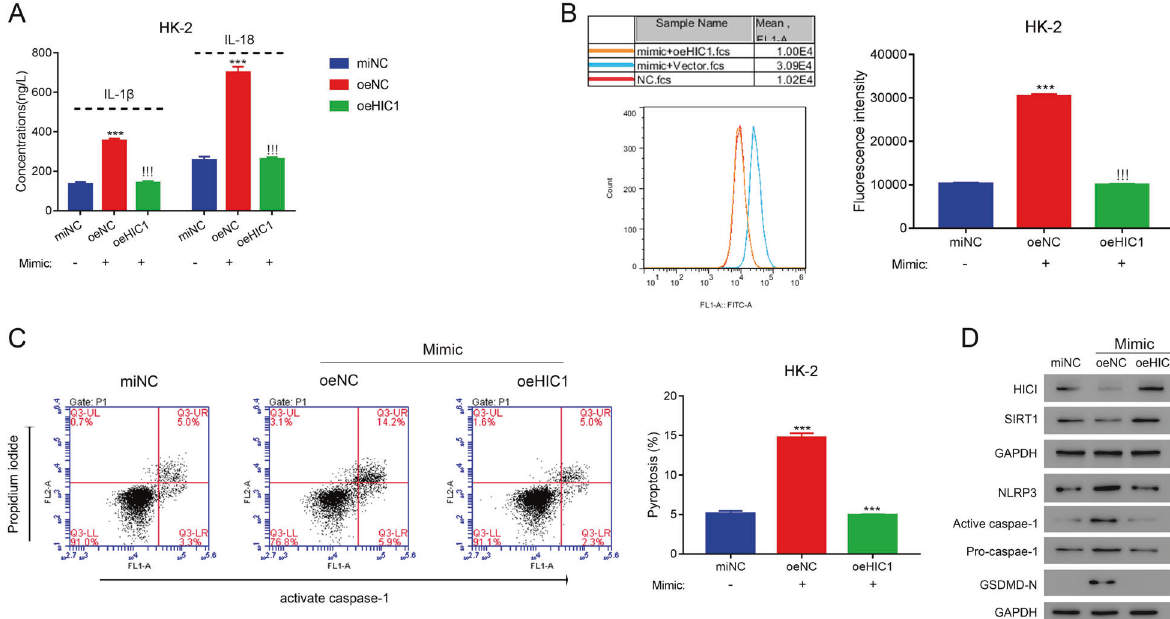
Fig. 8 HIC1 overexpression rescues the effect of miR-4449. HK-2 cells transfected with vehicle, empty vectors (oeNC), or HIC1 plasmid (oeHIC1) were treated with control miRNA ( − ) or miR-4449 mimic (mimic). A The secretions of IL-1 β and IL-18 were quanti fi ed using ELISA. B ROS levels were quanti fi ed using the DCFDA assay kit. C Pyroptosis was measured by quantifying cells with active caspase-1. D Expression of indicated proteins was measured by western blotting. *** P < 0.001 vs. miNC; !! P < 0.001 vs.